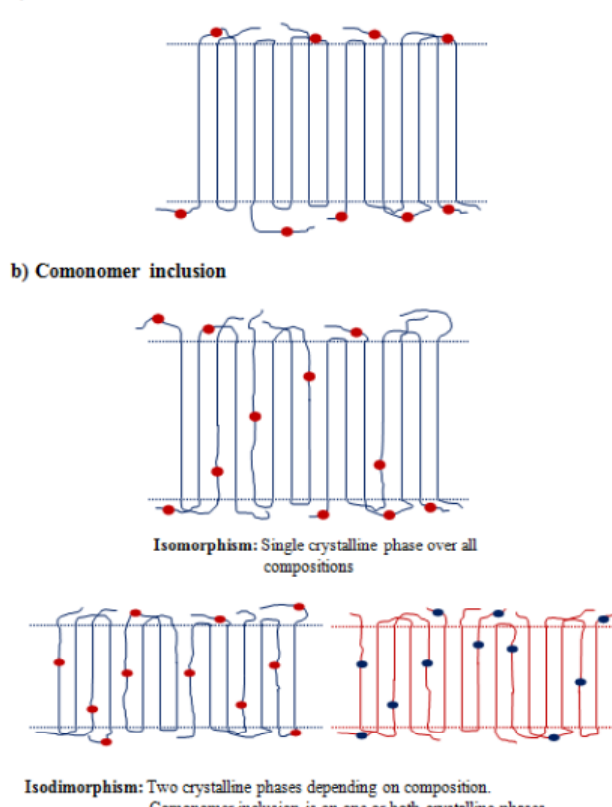
Figure 6. Scheme of the comonomer ( a ) and inclusion ( b ) arrangements in lamellae for full exclusion and inclusion models. In the latter case, isomorphic and isodimorphic structuresare considered. In the last case, the two crystalline phases are represented with blue and red colors and the comonomer inclusion has been drawn for both phases. Reproduced from Díaz et al. [104], copyright (2014), by permission of Elsevier Science